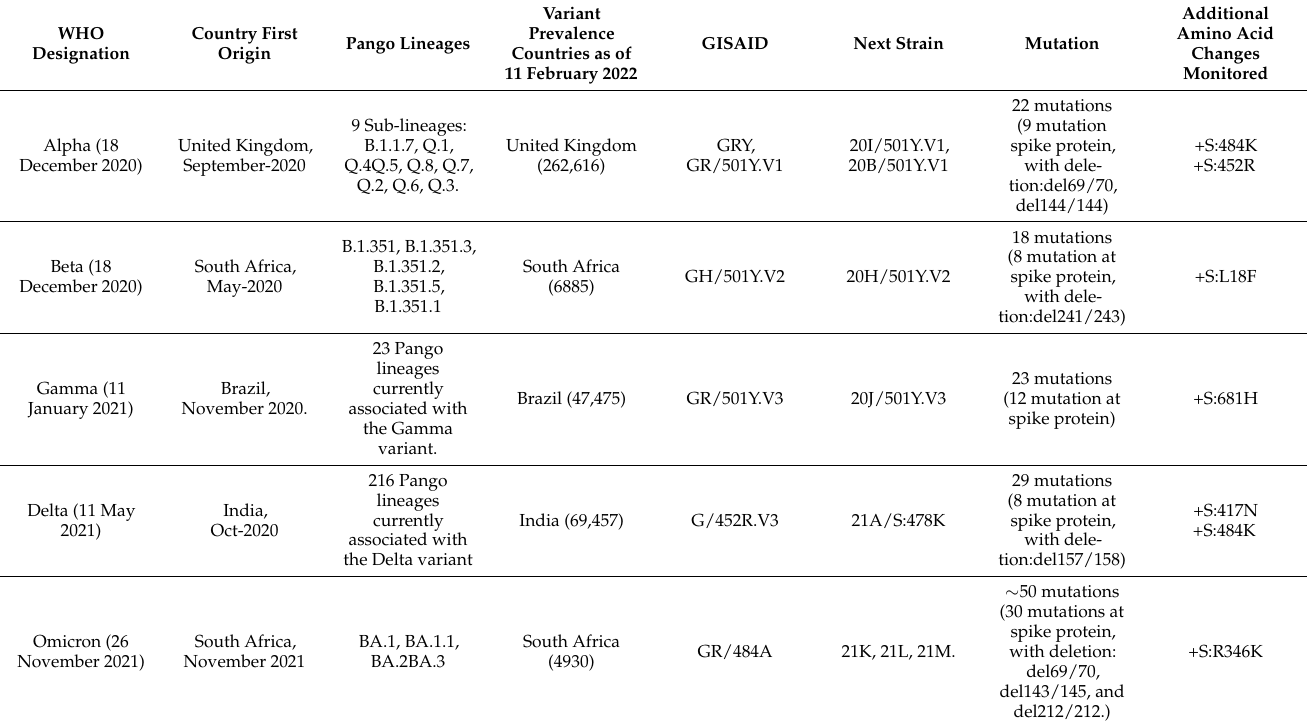
Table 1. WHO-designated SARS-CoV-2 variants of concern